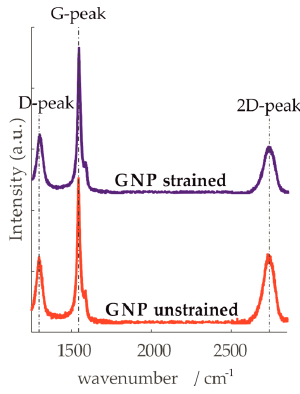
Figure A2. Representative Raman spectra with an excitation wavelength of 532 nm measured for unstrained (with 2D/G intensity ratio of 0.32) and strained (1%) state of a GNP film.